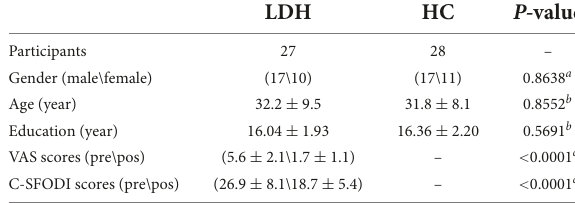
TABLE 1 Demographic characteristics of the LDH and HC groups.